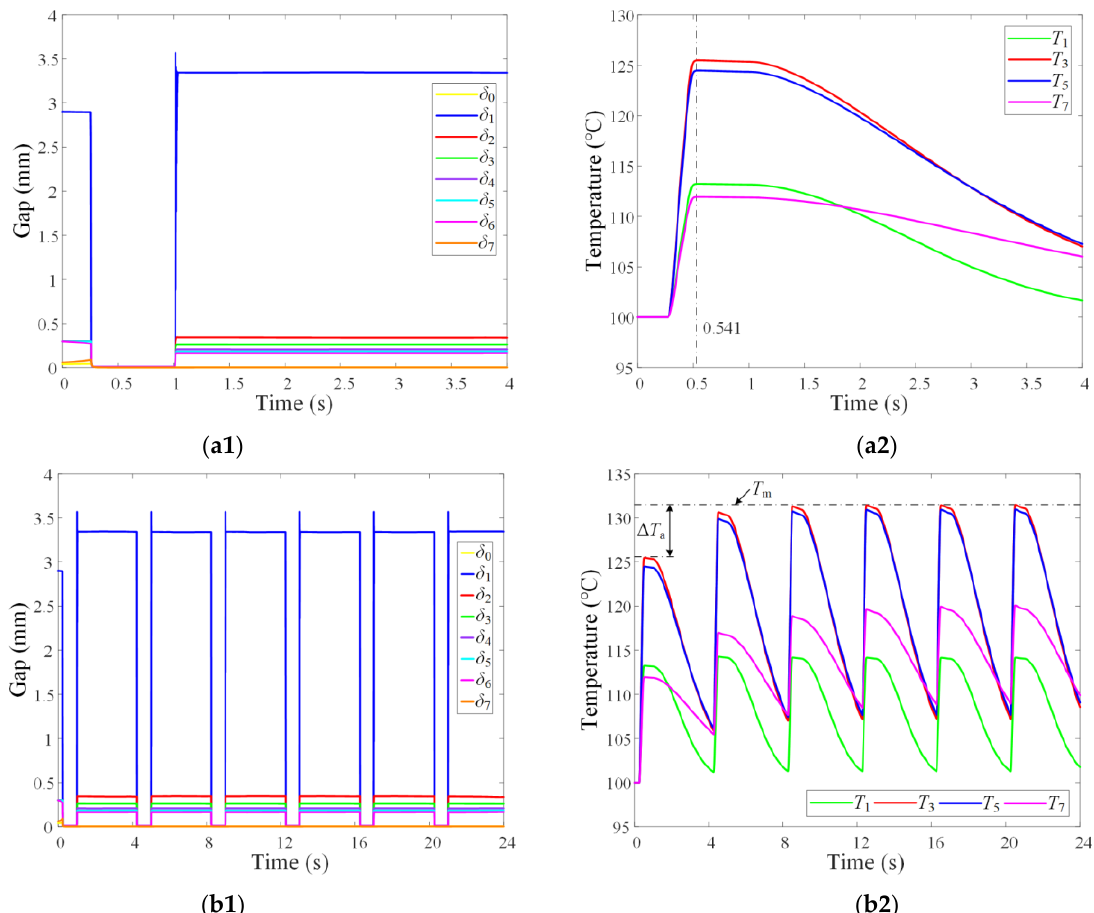
Figure 6. Variations of gaps and temperatures: ( a1 , a2 ) in the first working cycle; ( b1 , b2 ) in the six repeated working cycles.